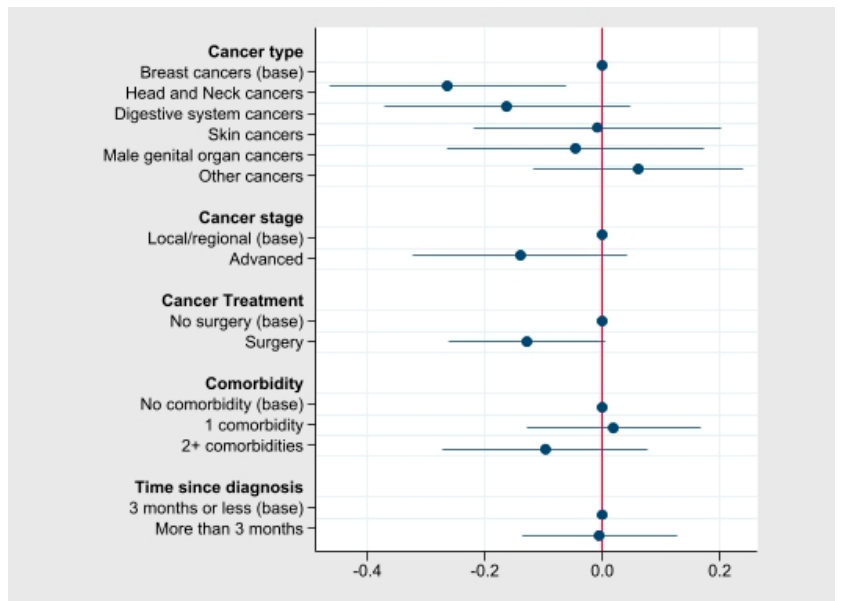
Figure 1. Crude associations between AQoL-4D utility scores and participant socio-demographic characteristics in cancer survivors (n = 63) in the first year of diagnosis, NT, Australia.